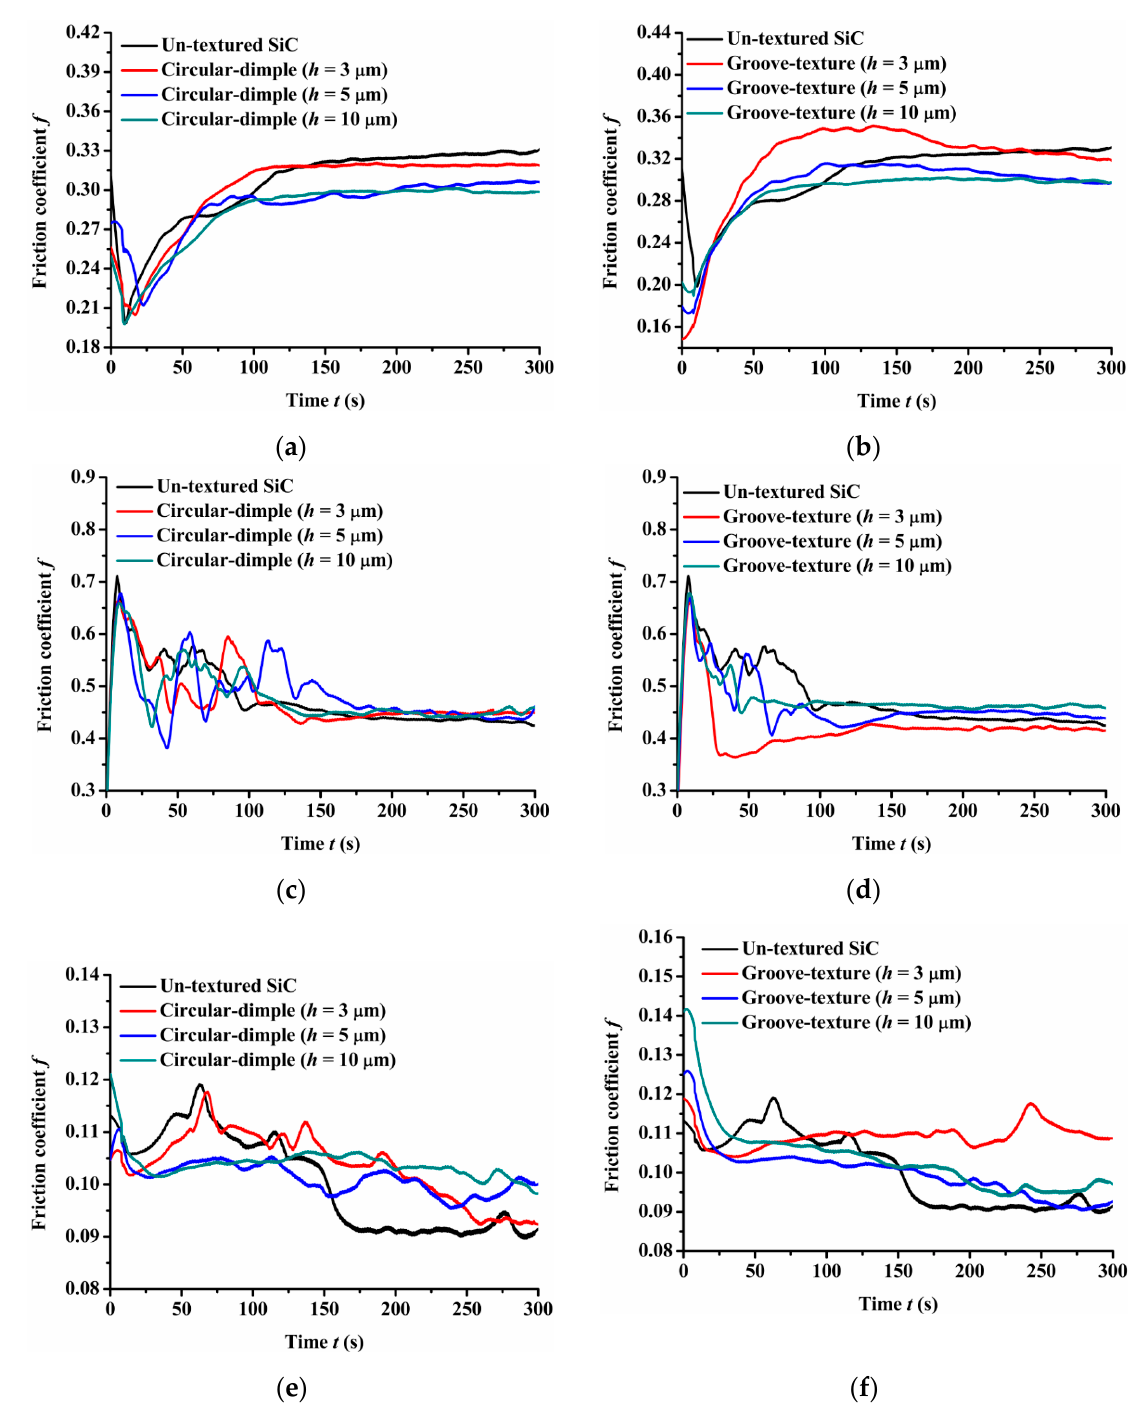
Figure 4. Friction performance of textured SiC under dry-friction conditions with a load of 30 N: ( a ) circular-dimple-textured SiC–steel ball, ( b ) groove-textured SiC–steel ball, ( c ) circular-dimple-textured SiC–Si 3 N 4 ball, ( d ) groove-textured SiC–Si 3 N 4 ball, ( e ) circular-dimple-textured SiC–PTFE ball, and ( f ) groove-textured SiC–PTFE ball.